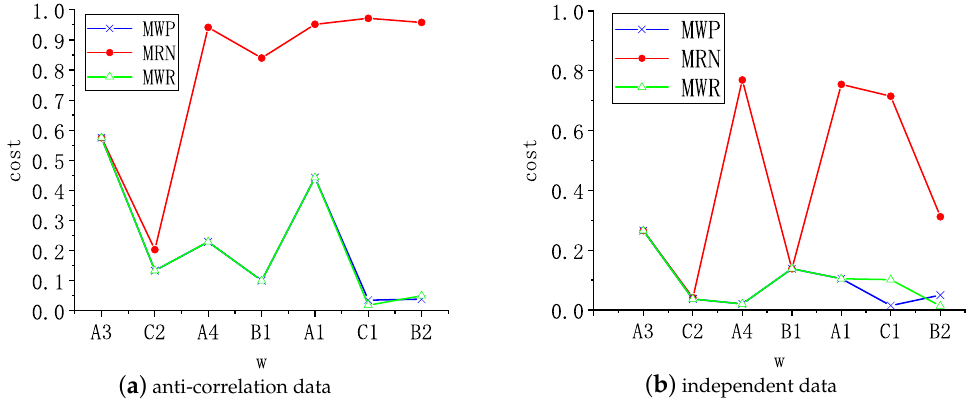
Figure 10. Cost for the MRE algorithm, where w (cid:54)∈ R